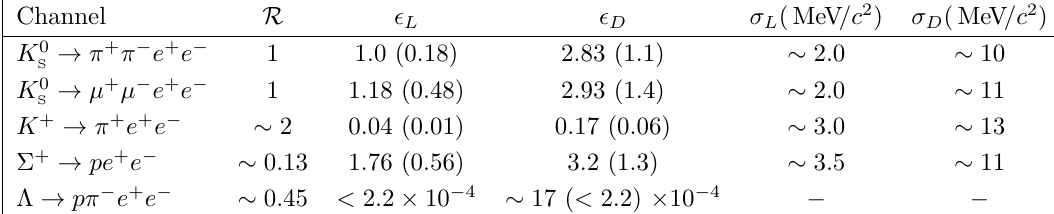
Table 2 . Acceptance scale factors (cid:15) , and mass resolutions (cid:27) , for only long ( L ) and only down- stream ( D ) tracks obtained from our simpli(cid:12)ed description of the LHCb Upgrade tracking system geometry. All e(cid:14)ciencies are normalised to that of fully reconstructed K 0 averaged between particles and anti-particles. The invariant-mass resolutions shown in the table correspond to the ideal case of perfect bremsstrahlung recovery.